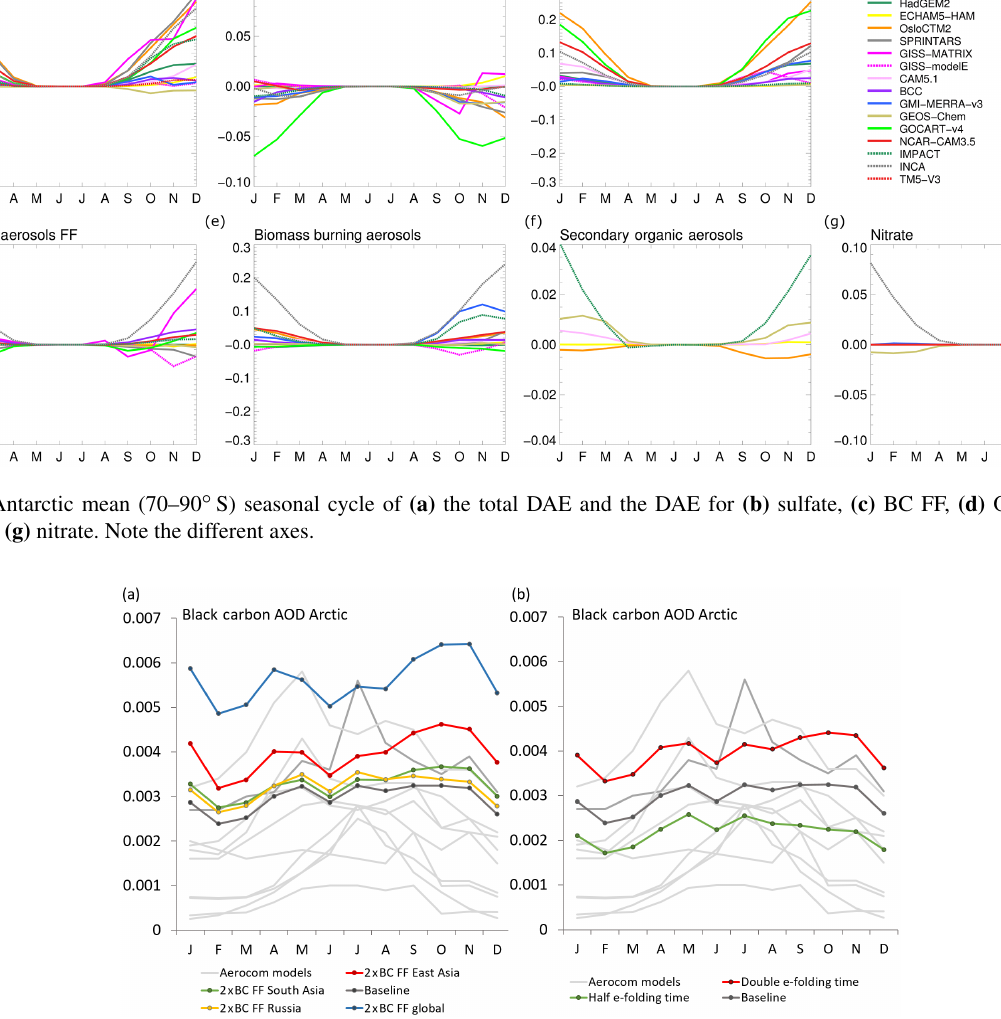
highest (positive) BC FF DAE also have the highest (nega- tive) sulfate DAE, as indicated by Myhre et al. (2013).